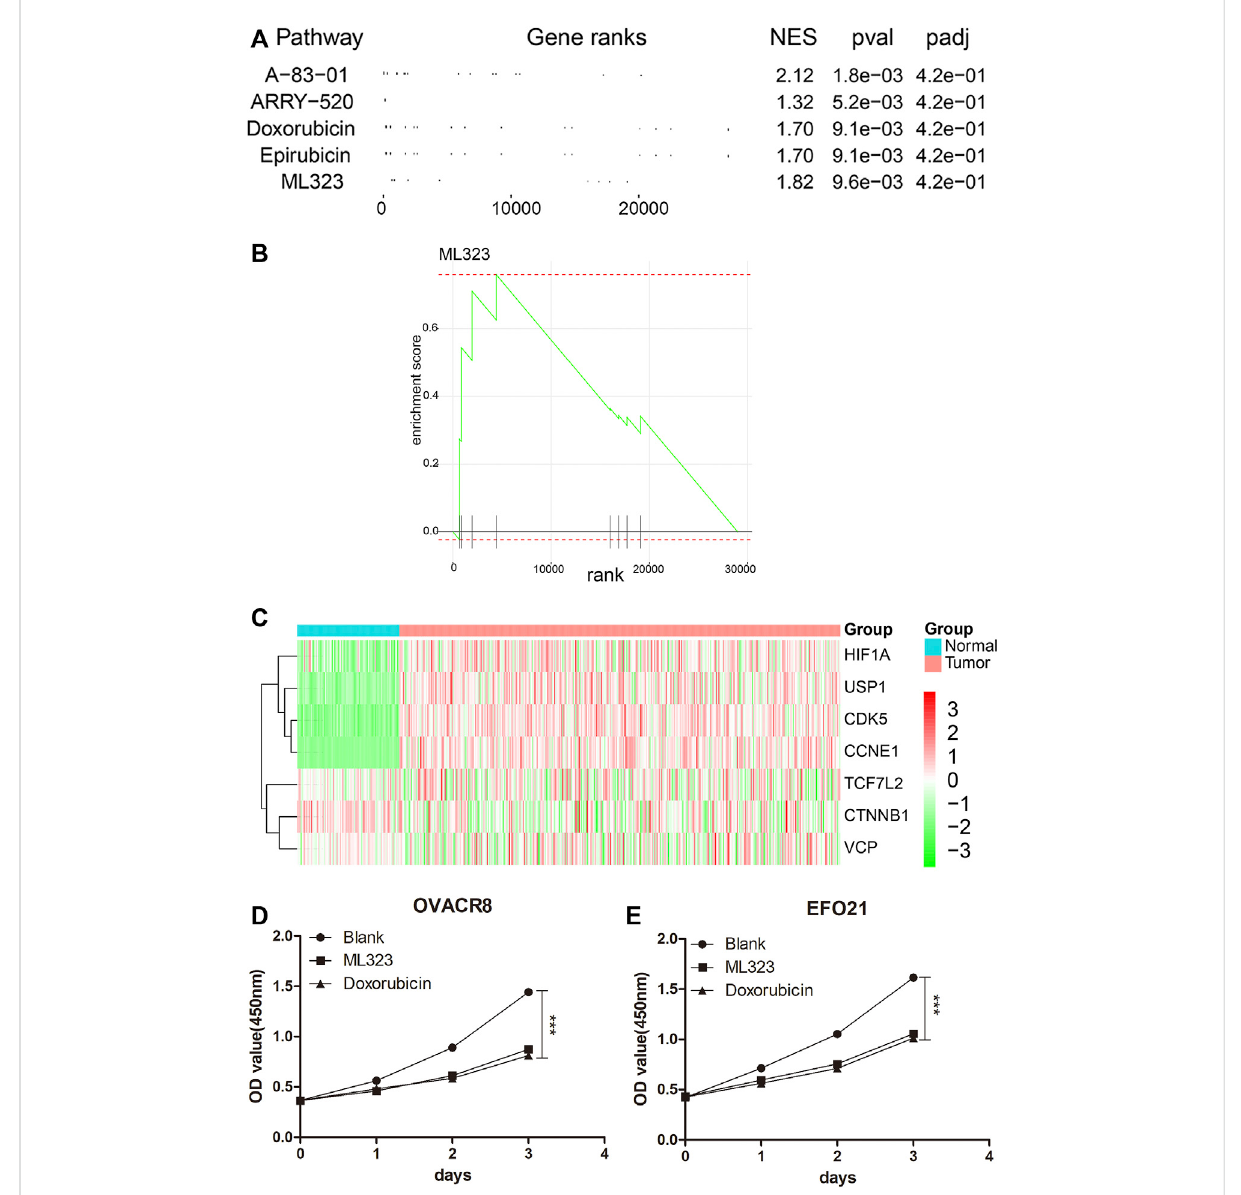
FIGURE 1 Screening for ML323, a small molecule drug for ovarian cancer. (A) The top fi ve drugs with anti-ovarian cancer effects were obtained by GSEA analysis. (B) GSEA analysis of ML323 and gene sets in OV samples. (C) Heat map of the target genes of the small molecule drug ML323. (D – E) ML323 inhibited the proliferation of OVACR8 and EFO21